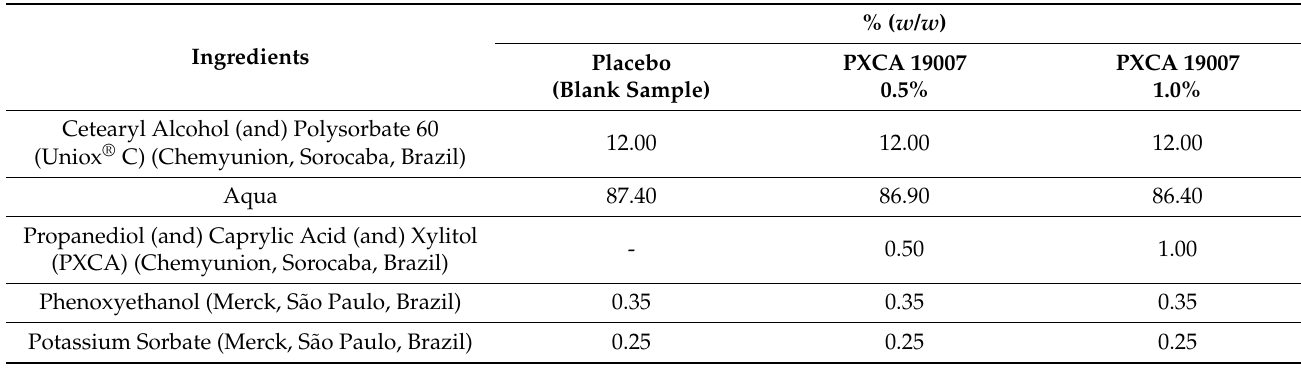
Table 1. Qualitative and quantitative (% w / w ) composition of the formulations (dermocosmetic samples—placebo and test